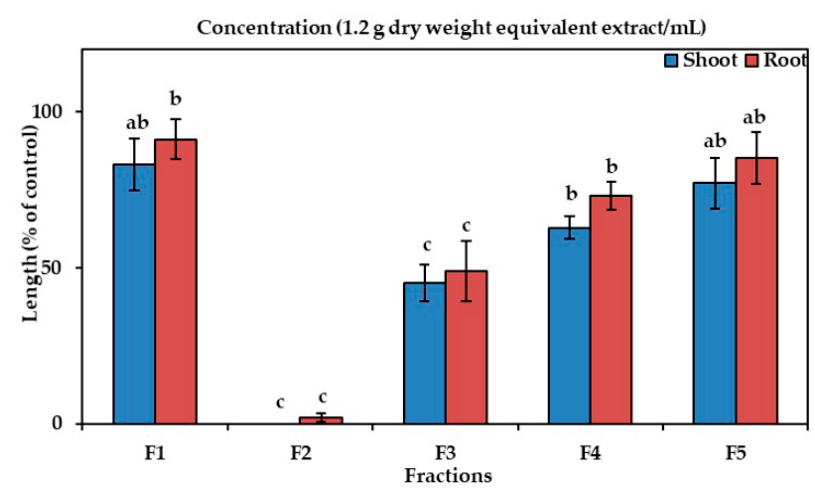
Figure 3. The allelopathic effect of Albizia richardiana extracts on shoot and root growth of cress. The cress seeds were treated in the concentration of 1.2 g DW equivalent extract/mL using the following fractions: F1 (20% aqueous methanol), F2 (40% aqueous methanol), F3 (60% aqueous methanol), F4 (80% aqueous methanol), and F5 (methanol). The means ± standard errors for every treatment from the two separate experiments with 10 seedlings are displayed. Various letters denote the significant differences according to Tukey’s HSD test at a 0.05 probability level.